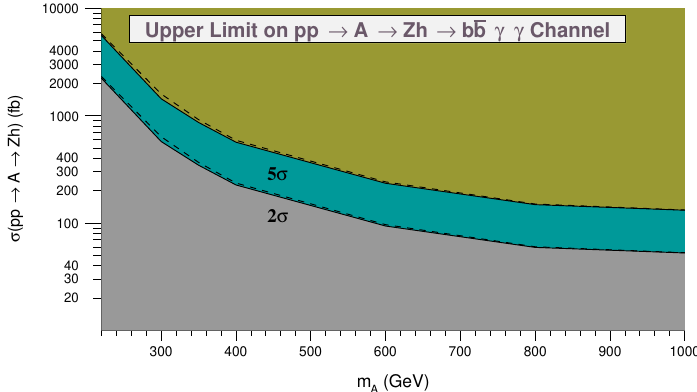
A Zh ) (fb) as a function of m A (GeV) for the b (cid:22) b(cid:13)(cid:13) ! !